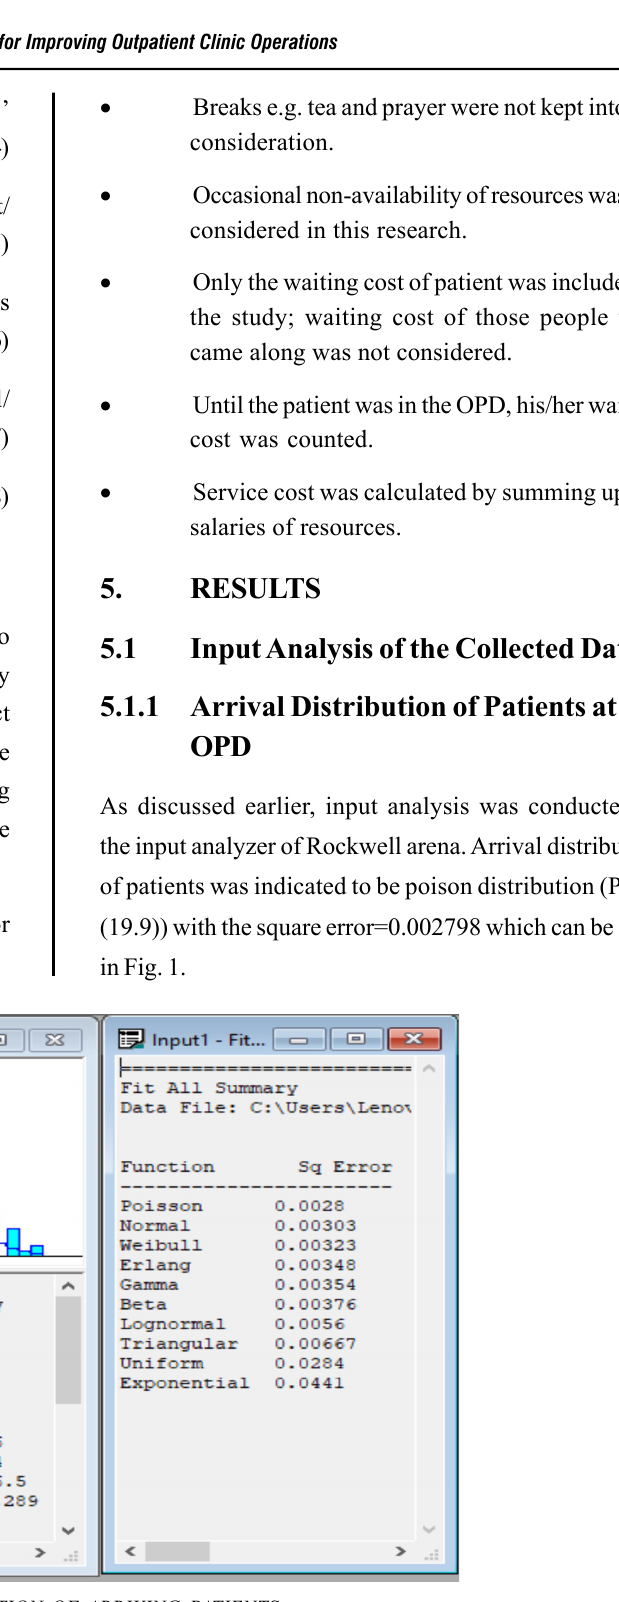
FIG. 1. DISTRIBUTION OF ARRIVING